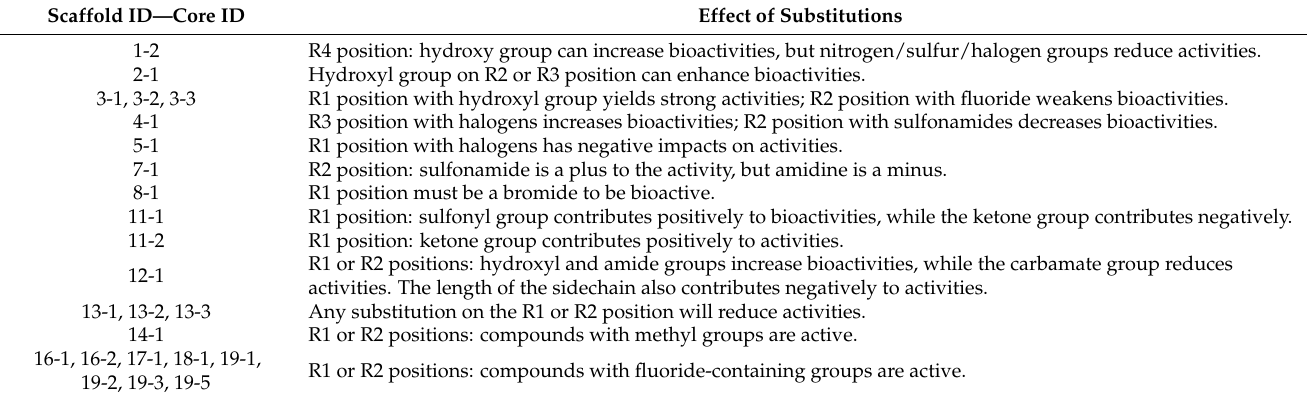
Table 5. List of the effects on functional group substitutions on core fragments, as shown in Figure 4c. Fragments with only one single substitution are not listed but discussed in the text. Effect of